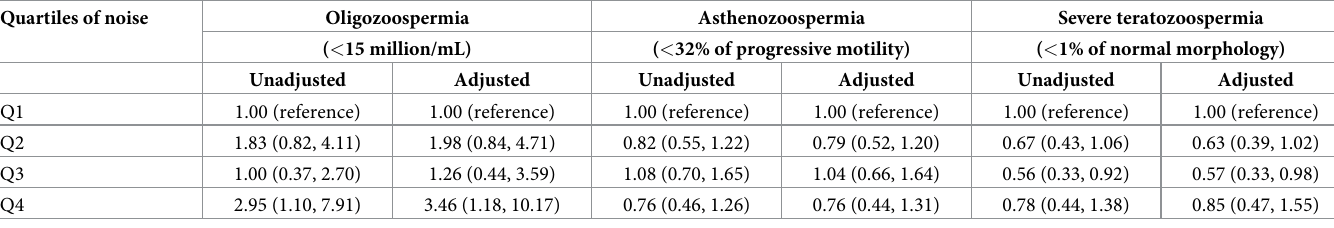
Confidence intervals of each odds ratio in parentheses. Covariates included were age and occupation at the time of semen analysis, season, fine particulate matter (PM 2.5 ) and deprivation index.